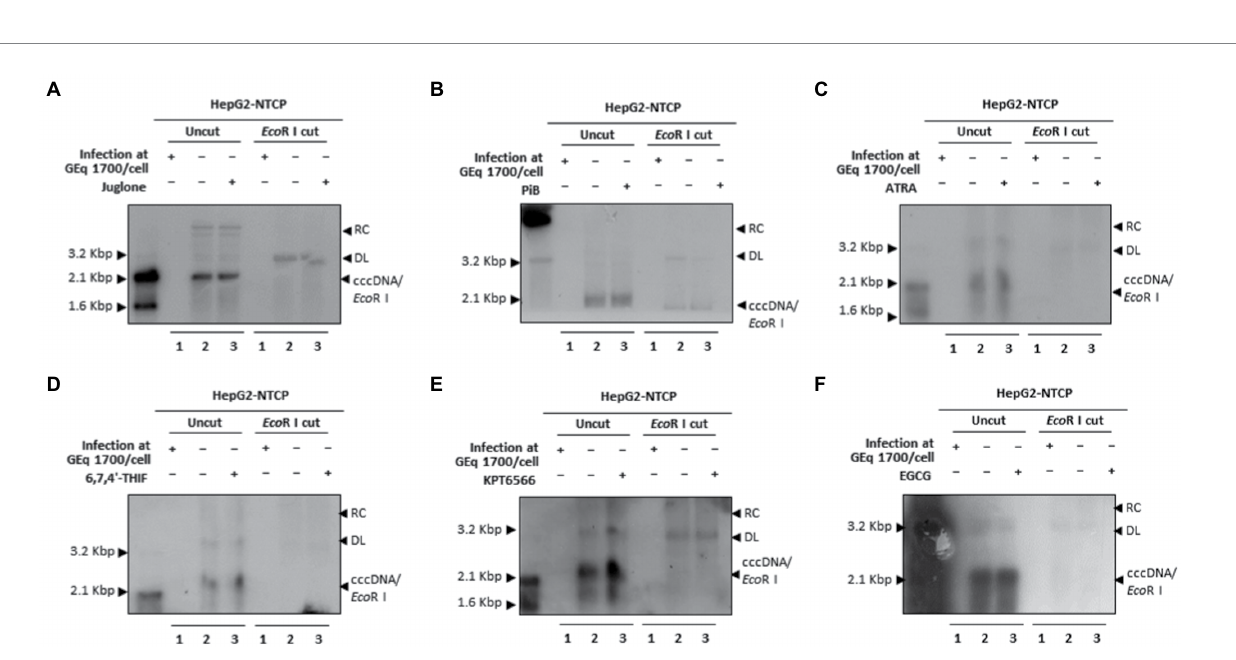
FIGURE 10 Juglone, PiB, ATRA, 6,7,4 ′ -THIF, KPT6566, and EGCG did not affect HBV cccDNA levels in HBV-infected cells. (A) Juglone, (B) PiB, (C) ATRA, (D) 6,7,4 ′ -THIF, (E) KPT6566, and (F) EGCG parvulin inhibitors did not affect HBV cccDNA levels. Mock-infected HepG2-hNTCP-C9 cells (lane 1) or HBV-infected HepG2- hNTCP-C9 cells (lanes 2–3) were treated with solvent (lane 2) or 20 μ M Juglone, 20 μ M PiB, 30 μ M ATRA, 30 μ M 6,7,4 ′ -THIF, 30 μ M KPT6566, or 40 μ M EGCG (lane 3) for 10 days. HBV cccDNA levels were determined by the Hirt extraction method, as described previously (Saeed et al., 2019). Data are presented from three independent